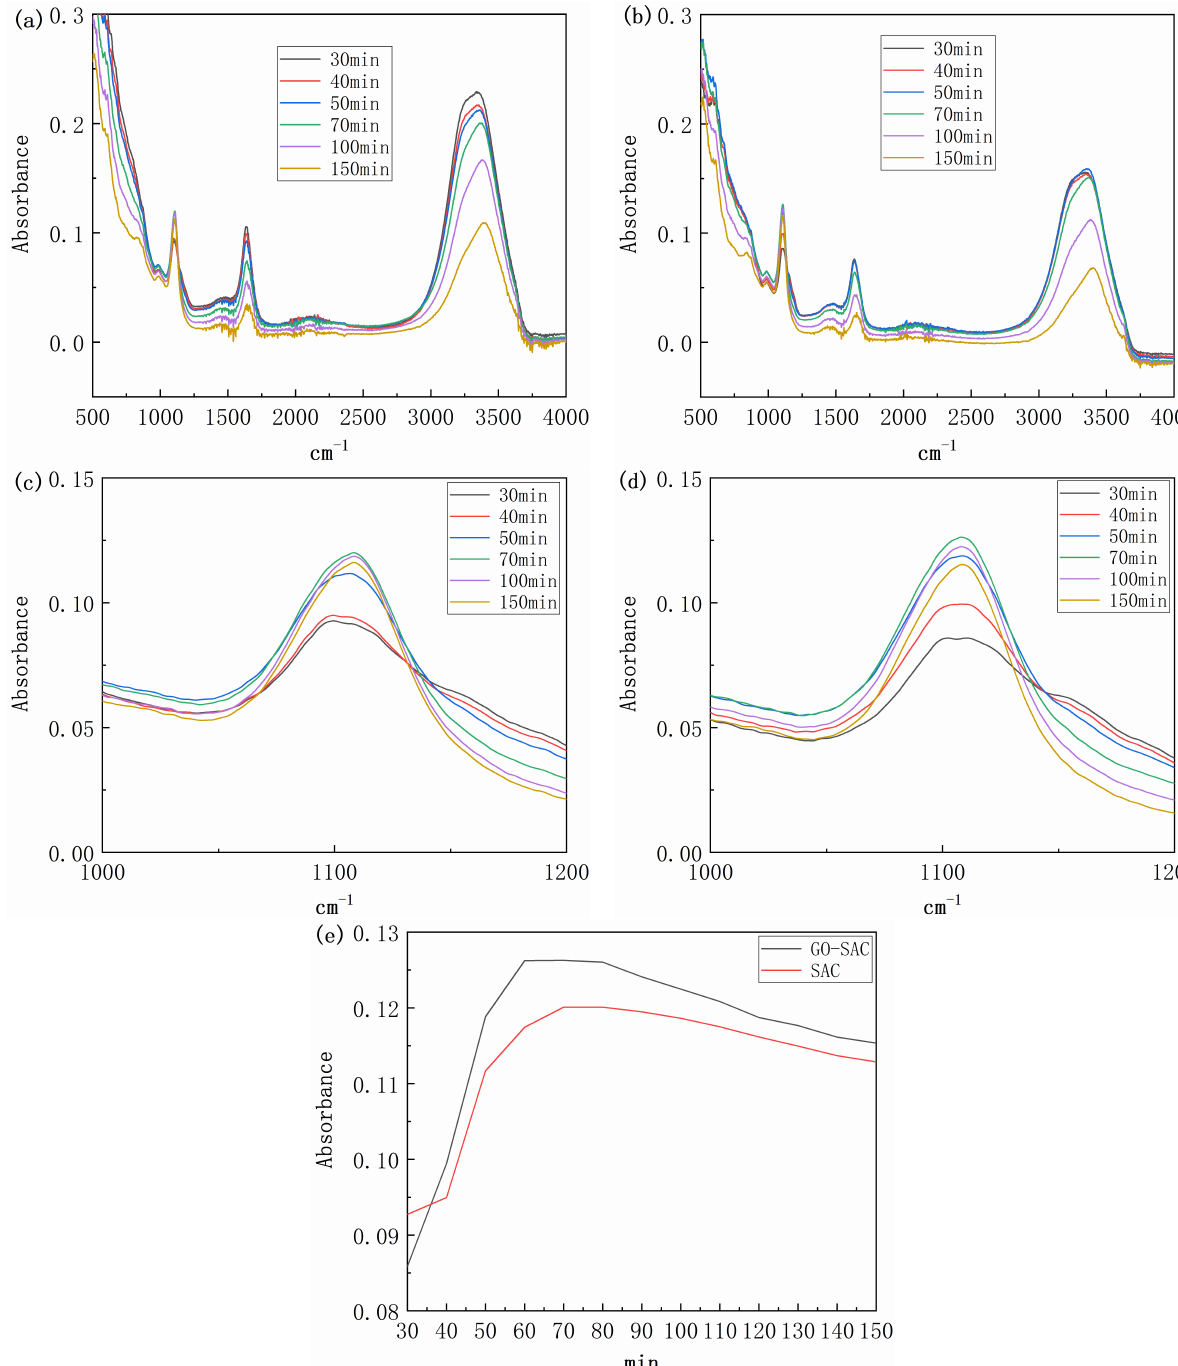
Figure 7: In situ ATR investigation. In situ ATR spectra of (a) SAC; (b) GO-SAC; the in situ ATR spectra from 1000 cm −1 to 1200 cm −1 of (c) SAC; (d) GO-SAC; (e) the peak-to-time relationships of AFt between SAC and GO-SAC.